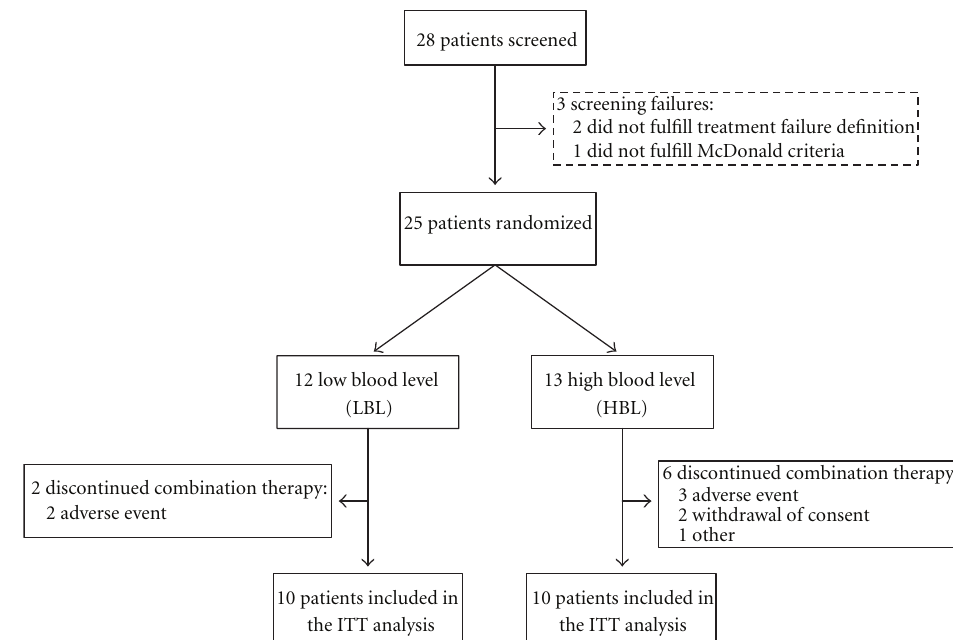
Figure 2: Patient enrollment flow chart. 25 patients who had met all required enrolment criteria were randomly assigned to receive low- blood-level tacrolimus (LBL) or high-blood-level tacrolimus (HBL). 10 LBL patients and 10 HBL patients completed the study and were included in the ITT